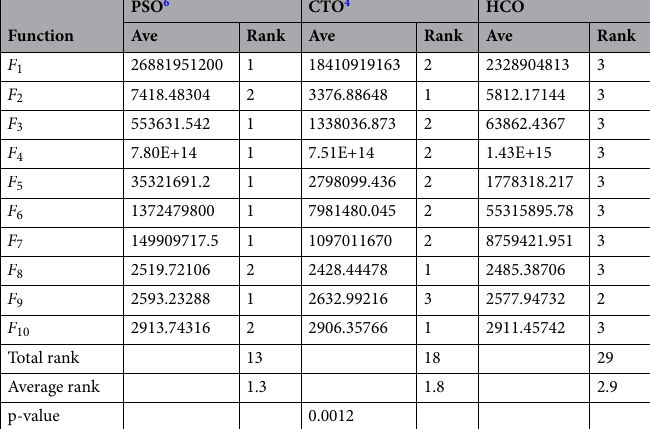
Table 6. Friedman test statistical data for 30D CEC2020